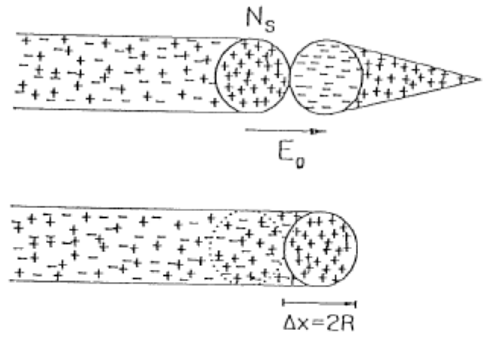
Figure 3. Schematic representation of the propagation of a streamer. In the diagram, the effects of multiple avalanches traveling towards the streamer head is represented by an equivalent avalanche. Adapted from [30]. As the charge on the head of the streamer is neutralized by the incoming avalanche, the streamer extends forward by a length ∆ x equal to the diameter of the streamer channel. In the diagram, N s is the number of positive ions at the head of the streamer and R is the radius of the streamer channel.